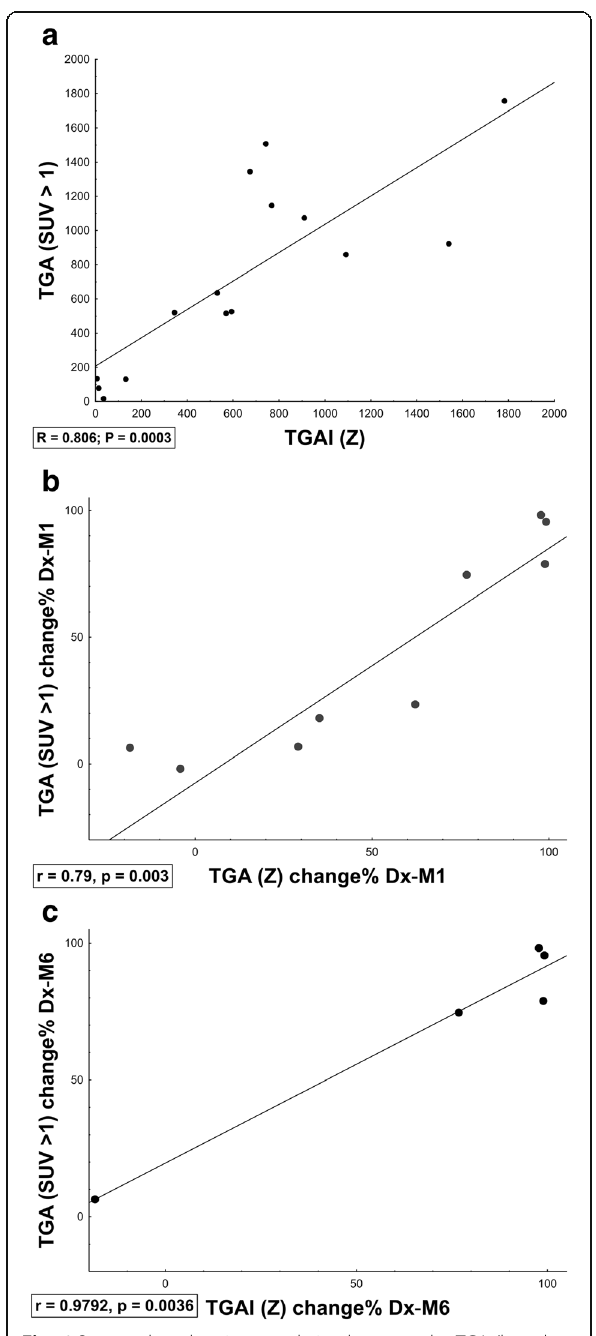
Fig. 6 Scatter plots showing correlation between the TGA (based on SUV and MLV determined by SUV > 1) and TGAI (based on lesion-to- background ratio and MLV created by Z -score). a Total values at Dx, M1 and M6. b Percentage change from Dx to M1. c Percentage change from Dx to